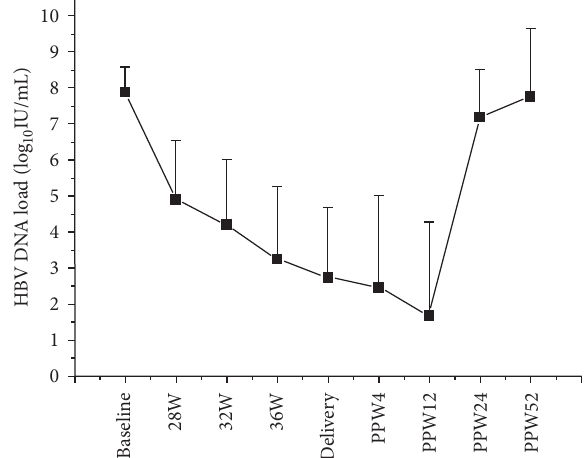
Figure 1: HBV DNA load kinetics in pregnancy and postpartum.